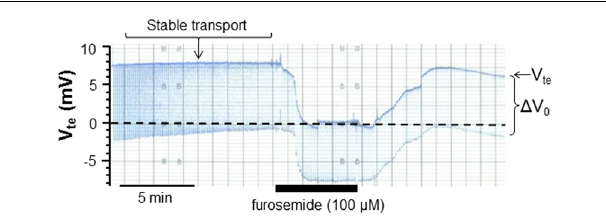
FIGURE 1 | Original recording of the lumen-positive transepithelial voltage (V te ) and voltage deflections ( (cid:2) V 0 ) in an isolated, perfused mouse medullary thick ascending limb (mTAL). Steady state conditions were reached after about 15min. The arrow indicates the time point used to quantify transport. In addition, the reversible blocking effect of luminal furosemide (100 μ M) is